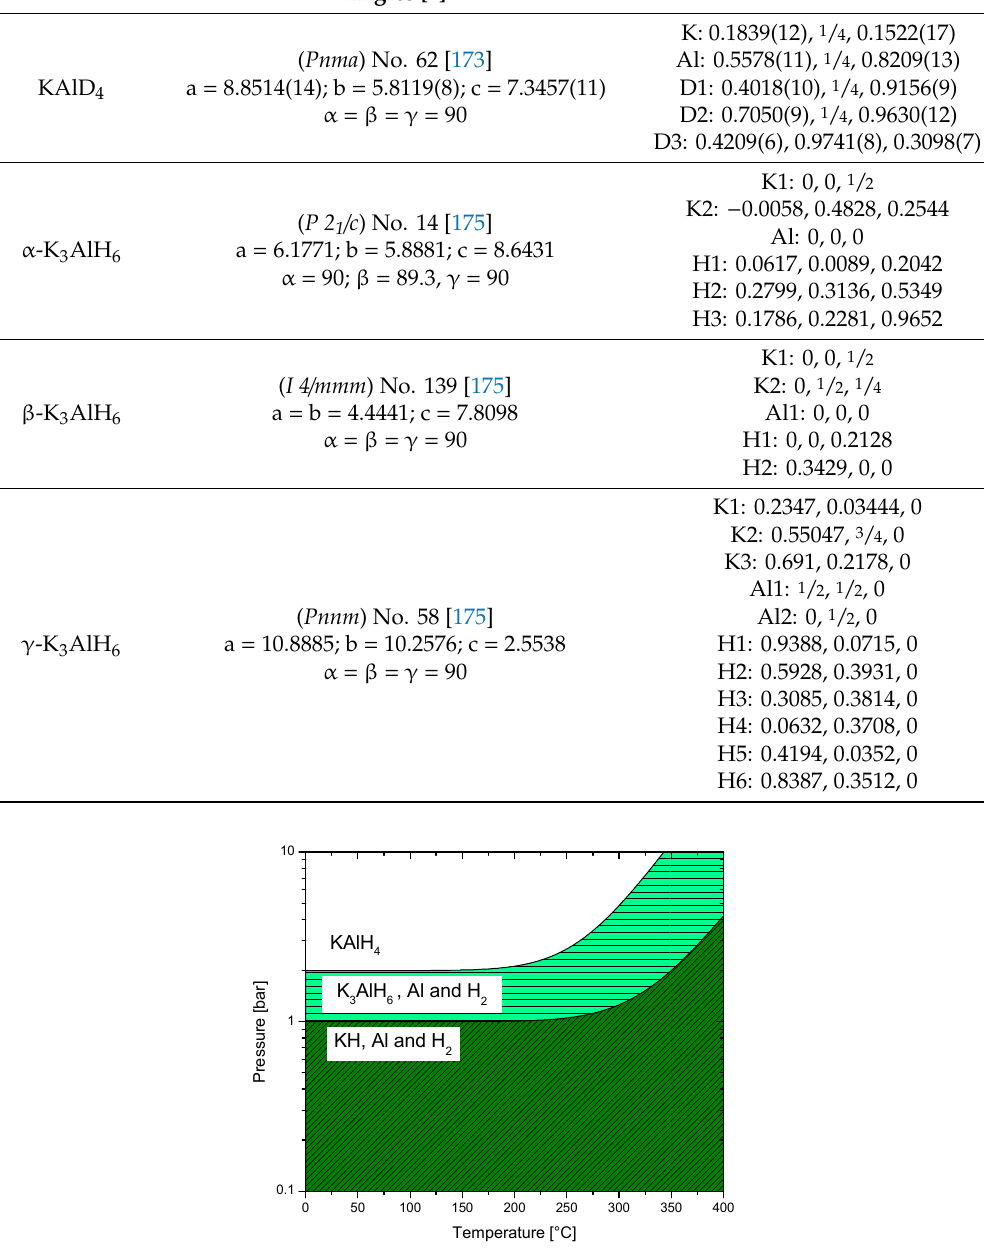
Figure 10. Phase diagram of KAlH 4 , K 3 AlH 6 , and KH + Al. Constructed with data of reference [167]